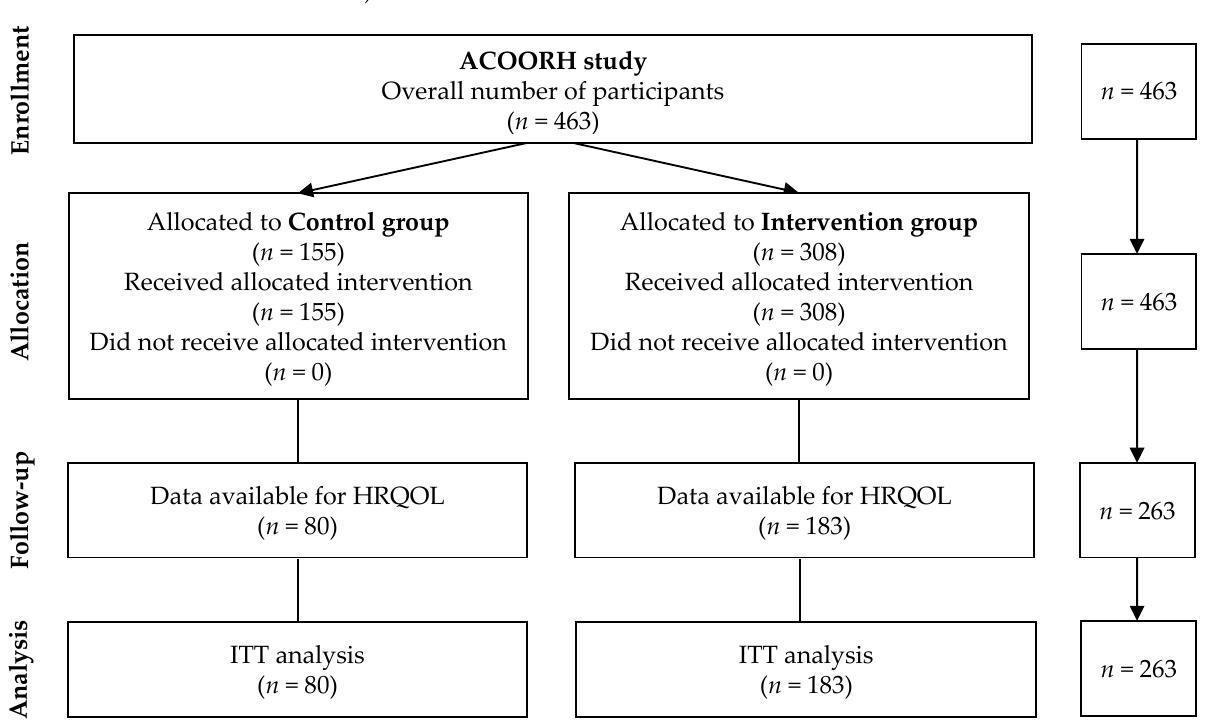
Figure 1. Flow chart. ACOORH: Almased Concept against Overweight and Obesity and Related Health Risk; HRQOL: health-related quality of life; ITT: intention-to-treat. Baseline characteristics (Table 1) did not differ significantly between groups, with the exception of higher values for BMI and weight in the control group. Table 1. Baseline